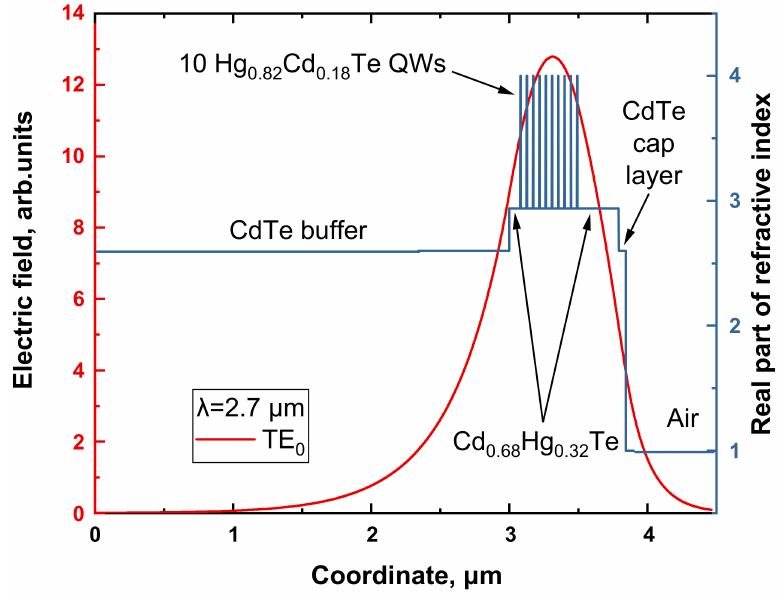
Figure 1. Distribution of real part of refractive index and TE 0 mode localization for the structure under study at the wavelength λ = 2.7 µ